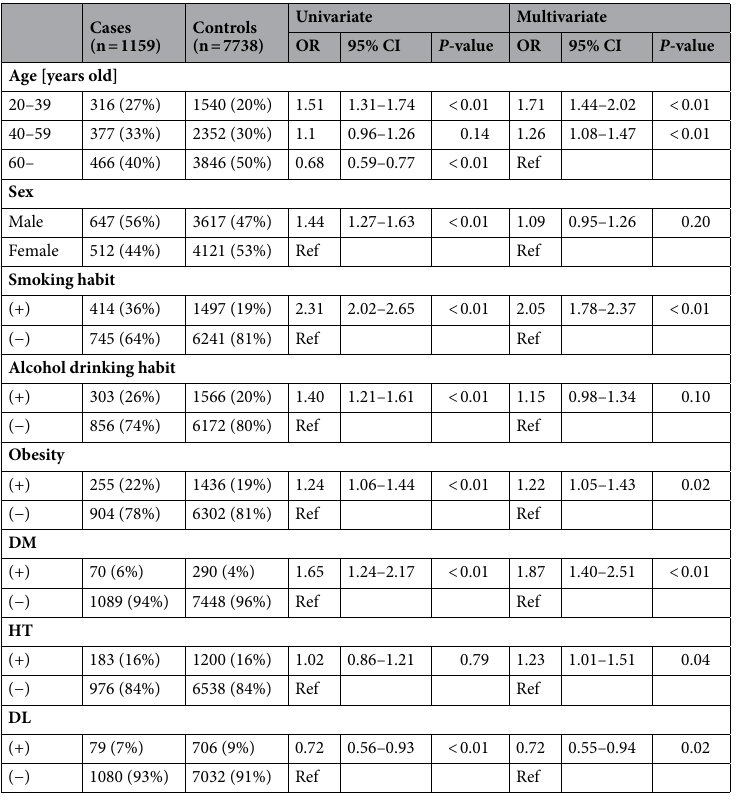
Table 4. Sample characteristics and univariate and multivariate analyses of risk factors for sarcoma. Ref reference, DM Diabetes mellitus, HT Hypertention, DL Dyslipidemia, OR Odds ratio, CI Confidence interval.